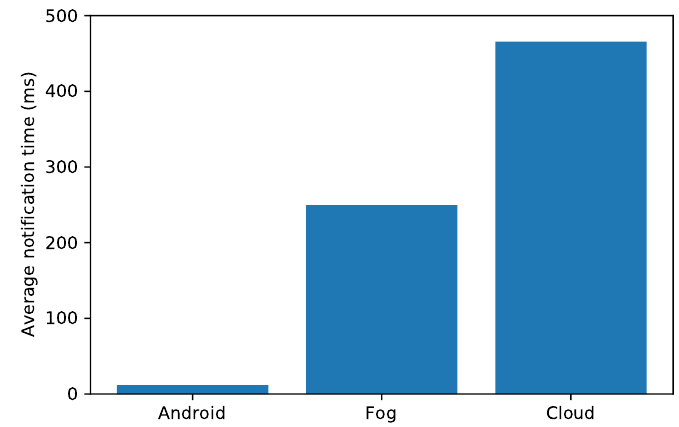
Figure 15. Average notification times in different scenarios.